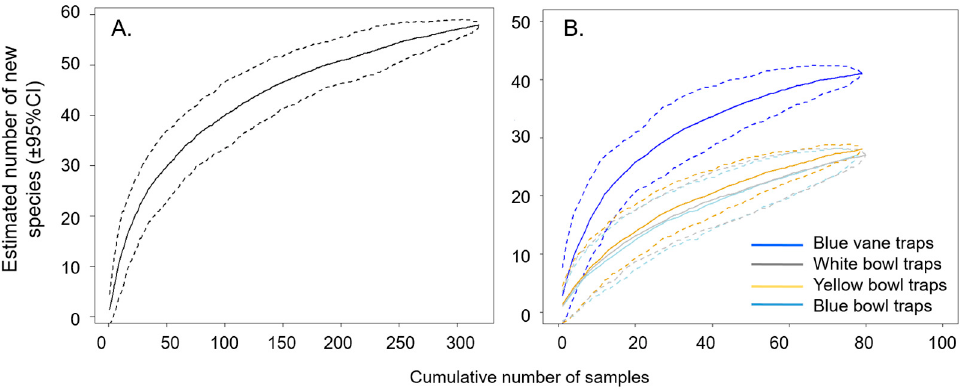
Figure 5. Species accumulation curves for bees surveyed in commercial potato fields in Michigan. Bees were collected in four different trap types at 12 field sites during the 2016 growing season. Species accumulation curve for all trap types pooled together ( A ) and by trap type ( B ). Dashed lines indicate 95% confidence intervals.